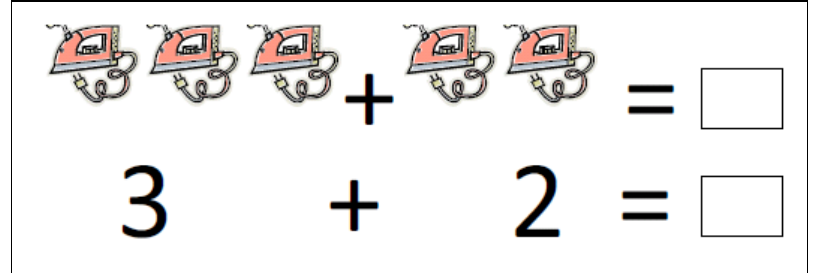
Figure 1 : Introduction of the equal sign in Maths for